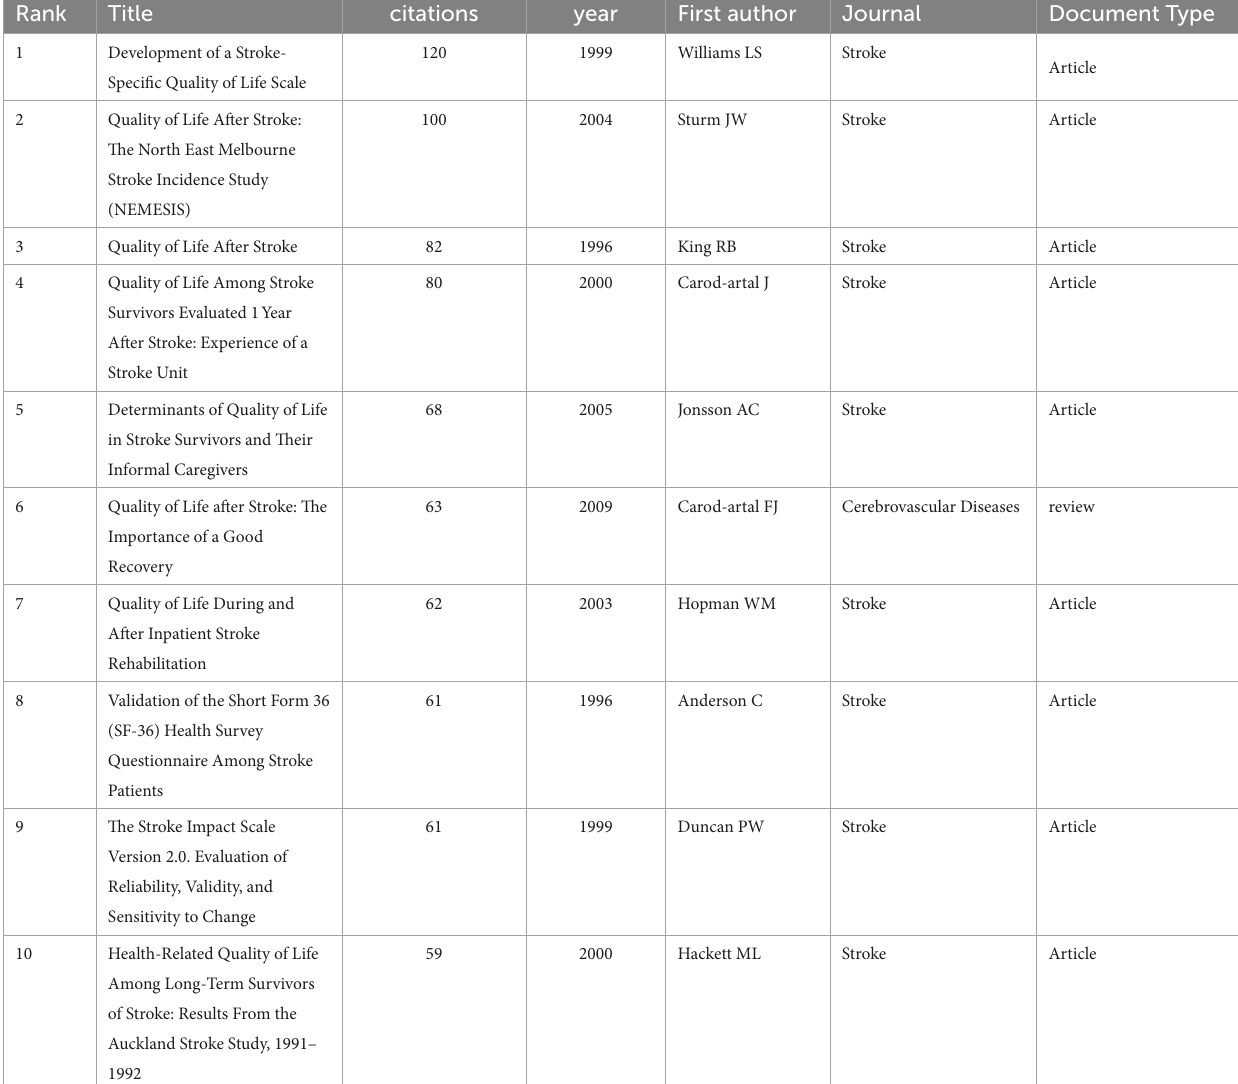
TABLE 4 Top 10 co-cited references in terms of